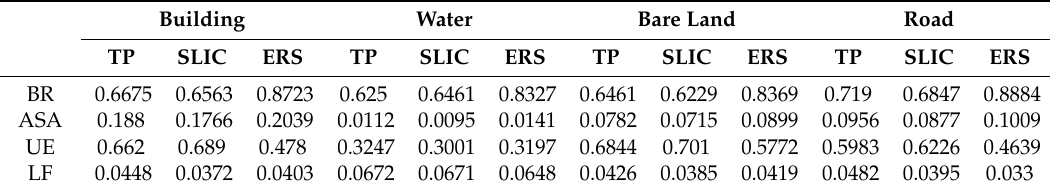
Table 4. The evaluation of over-segmentations of TIANHUI image while using Turbo Pixel (TP), SLIC and